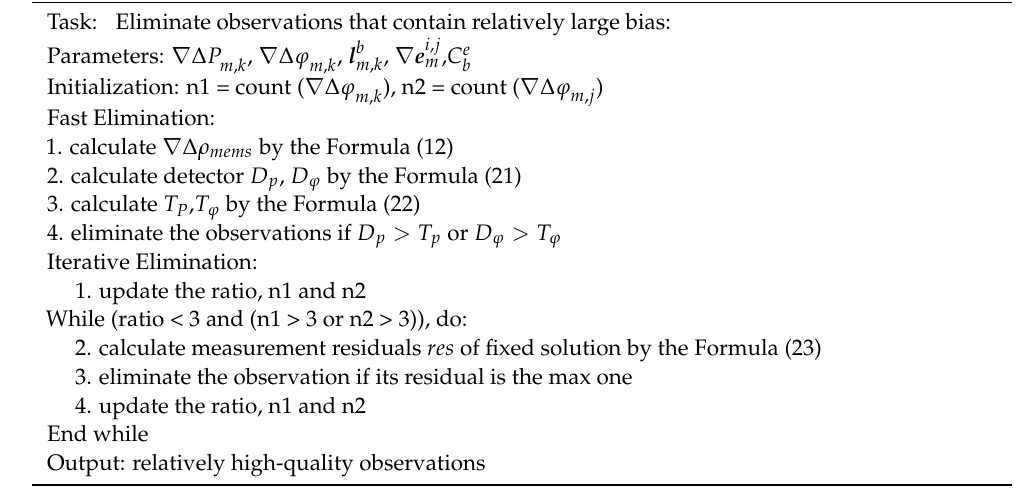
Algorithm 1. MEMS Attitude aid Quality-Control